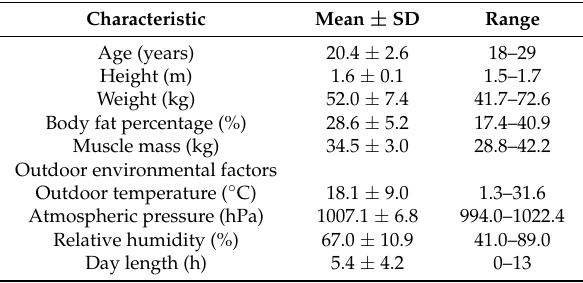
Table 1. Characteristics of the study population and outdoor environmental factors ( n = 53).